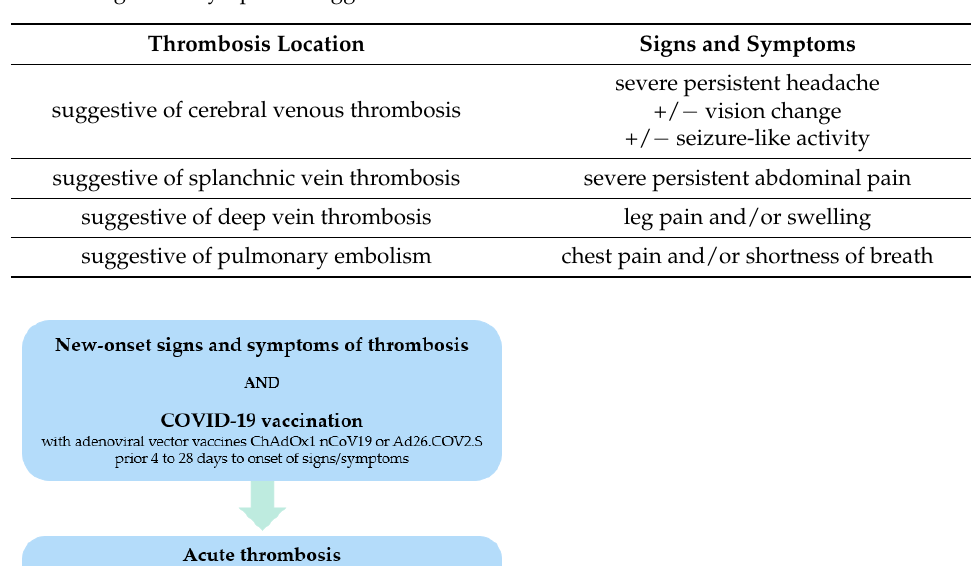
Table 2. Signs and symptoms suggestive of venous thrombosis with VITT.